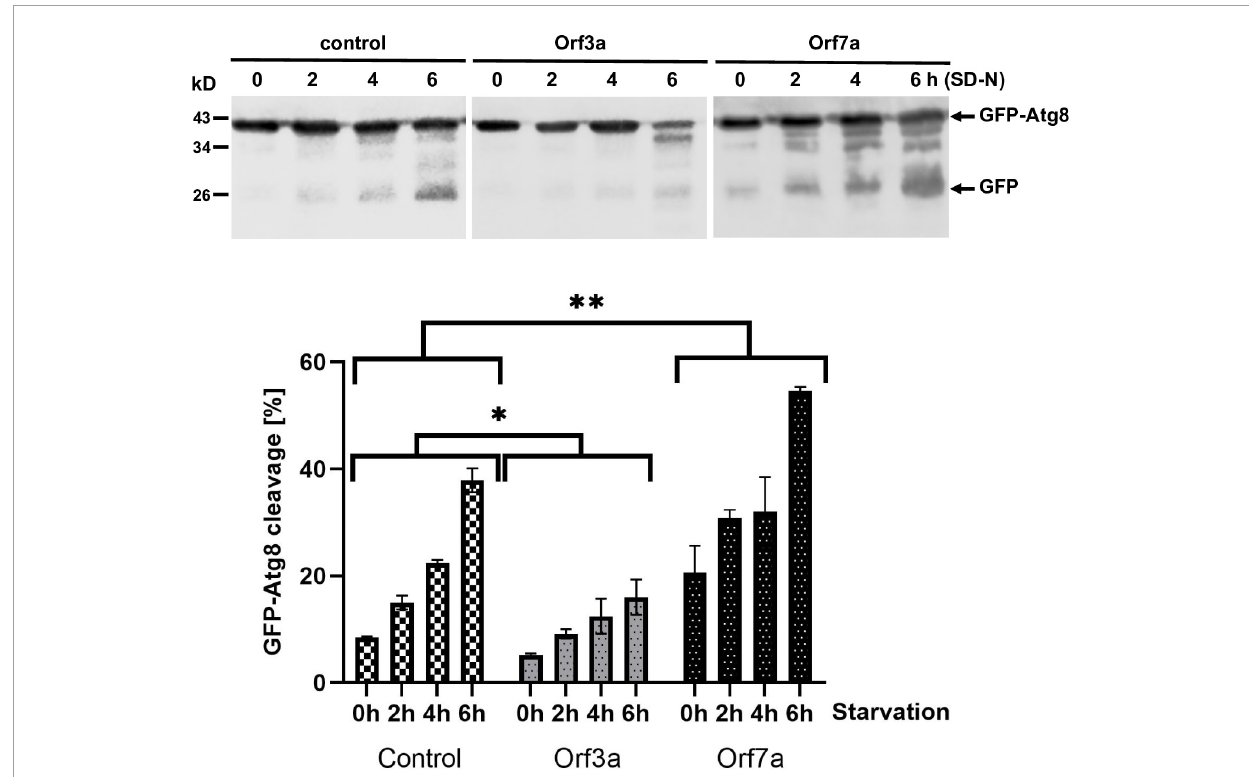
FIGURE5 Effects of severe acute respiratory syndrome coronavirus-2 (SARS-CoV-2) ORF3a and ORF7a overexpression on the autophagic digestion of GFP-Atg8. GFP-tagged Atg8 was constitutively expressed in yeast cells in the presence or absence (control) of ORF3a or ORF7a. (A) Immunological detection of full length GFP-Atg8 or proteolytically cleaved GFP before and during starvation in SD-N medium. (B) Representation of the relative GFP-Atg8 cleavage. Three independent biological samples were analyzed. Data are mean ± SD. ∗ p < 0.05; ∗∗ p < 0.01 (unpaired Student’s t -test) for significant differences between control and overexpressor cell